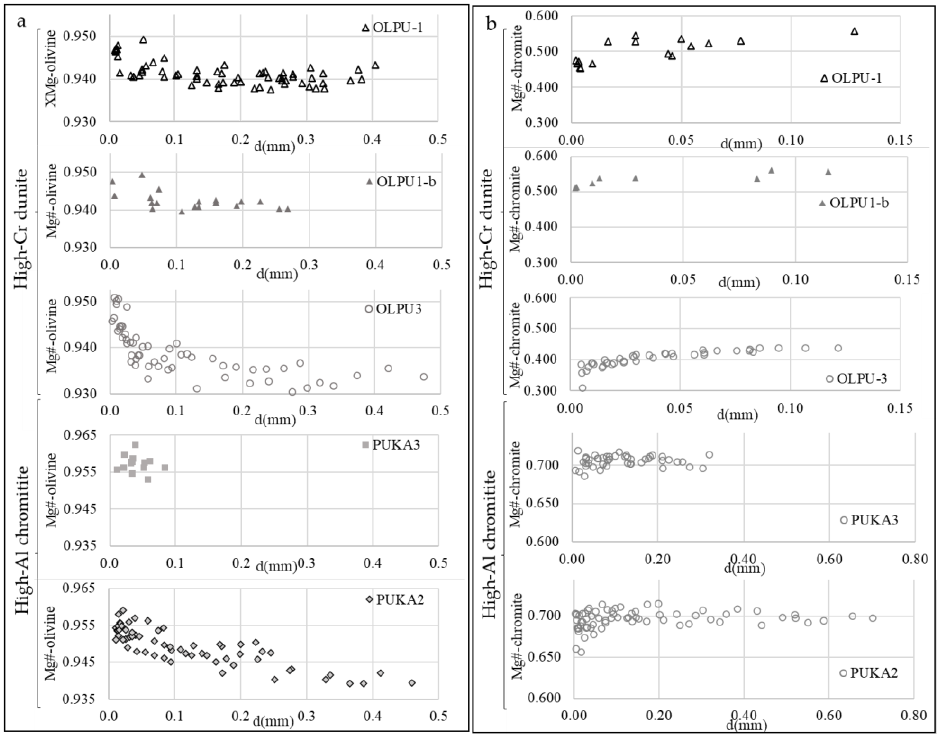
Figure 8. Mg# vs. distance (d) from the grain boundary (mm) of ( a ) olivines in dunites and chromitites and ( b ) chromites in dunites and chromitites at Iballe.